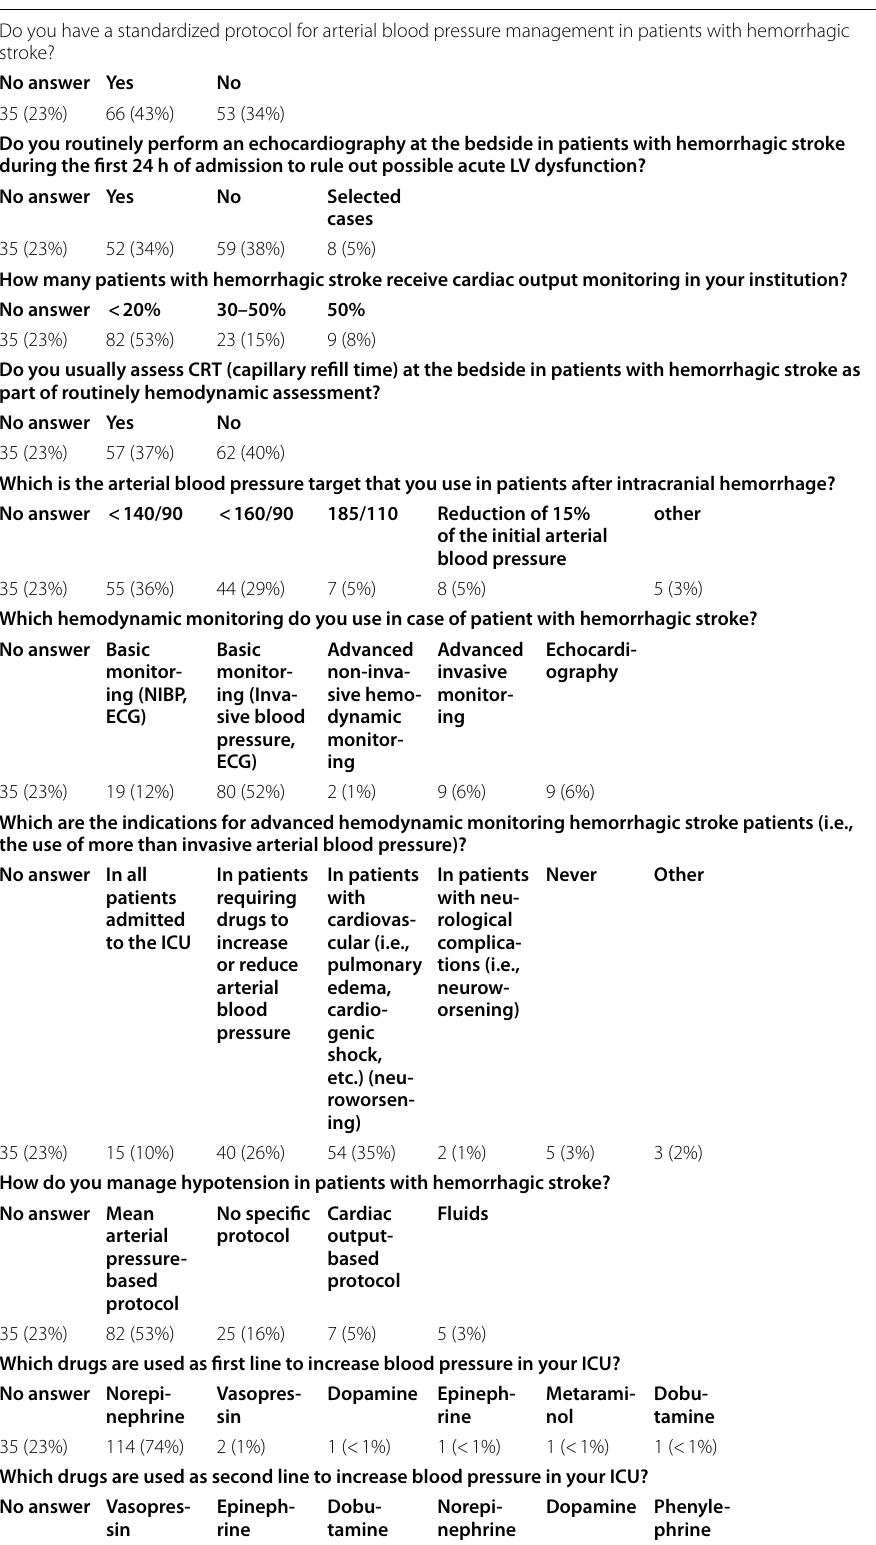
Table 3 Questions and answers on hemorrhagic